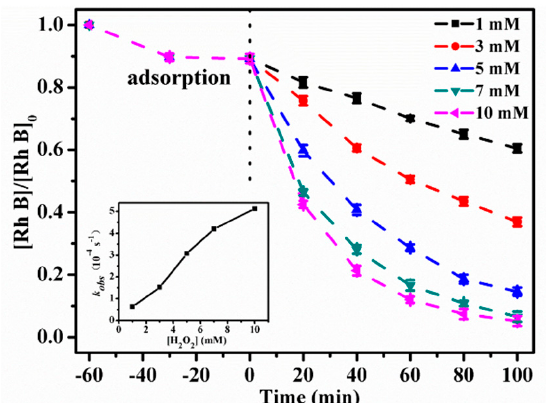
Figure 10. [Rh B]/[Rh B] 0 as a function of time and the corresponding reaction rate constants (insert) with different H 2 O 2 concentrations in the presence of 1 g/L of the Cu/Al 2 O 3 /CN composite at room temperature. Reaction conditions: [Rh B] 0 = 20 mg/L, V = 100 mL, pH 4.9 (unadjusted).